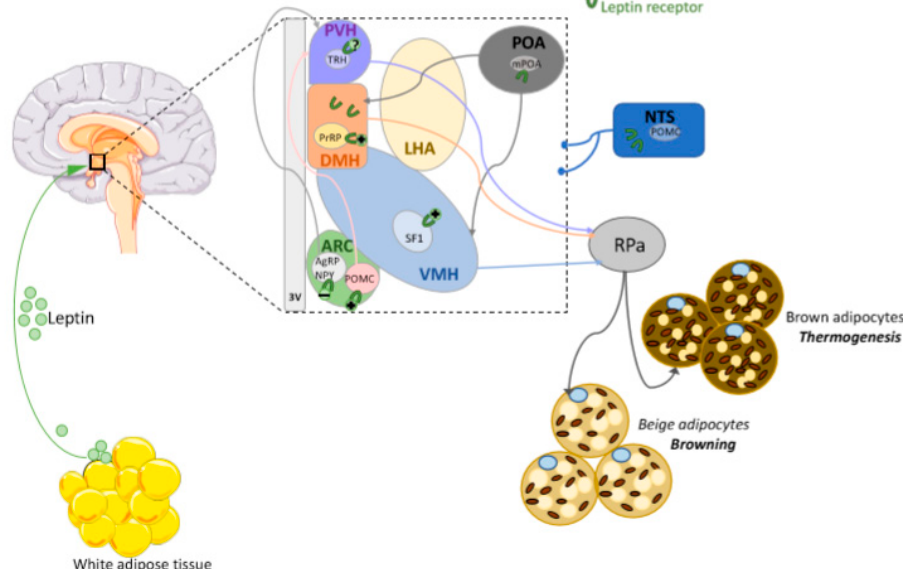
Figure 4. Hypothalamic leptin-sensitive neurons regulating thermogenesis and browning. The leptin receptor (LepR) is highly expressed in several hypothalamic areas implicated in the thermogenic program. The Dorsomedial Hypothalamus (DMH) (high density of LepR), the Preoptic Area (POA) and the Steroidogenic Factor 1 (SF1) expressing neurons of the ventromedial hypothalamus (VMH) have a significant role in the control of the Sympathetic Nervous System (SNS) outflow to the brown adipose tissue (BAT) and the white adipose tissue (WAT) to control thermogenesis and browning respectively. Neurons in these areas are interconnected and can control the sympathetic activity regulating downstream effector neurons in the Raphe Pallidus (RPa). The Arcuate nucleus of the hypothalamus (ARC) also has high expression of LepR: different ARC neuronal populations exert opposing effects on the thermogenesis through the inhibition of Agouti-Related Protein (AgRP)/Neuropeptide Y (NPY) neurons and activation of Pro-opiomelanocortin (POMC) ones. These neurons can act on the Paraventricular nucleus of the hypothalamus (PVH) to decrease or induce thermogenesis respectively. LepR is also expressed in extra-hypothalamic areas, such as POMC neurons in the Nucleus of the Solitary Tract (NTS); these neurons project to different hypothalamic nuclei but their actions are distinct from the POMC expressing neurons of the ARC. Although LepR is expressed in the PVH the role of the PVH in regulating thermogenesis is not completely clear, likely via indirect connections with another nucleus. TRH: thyrotropin-releasing hormone. PrRP: prolactin releasing peptide. mPOA: medial POA